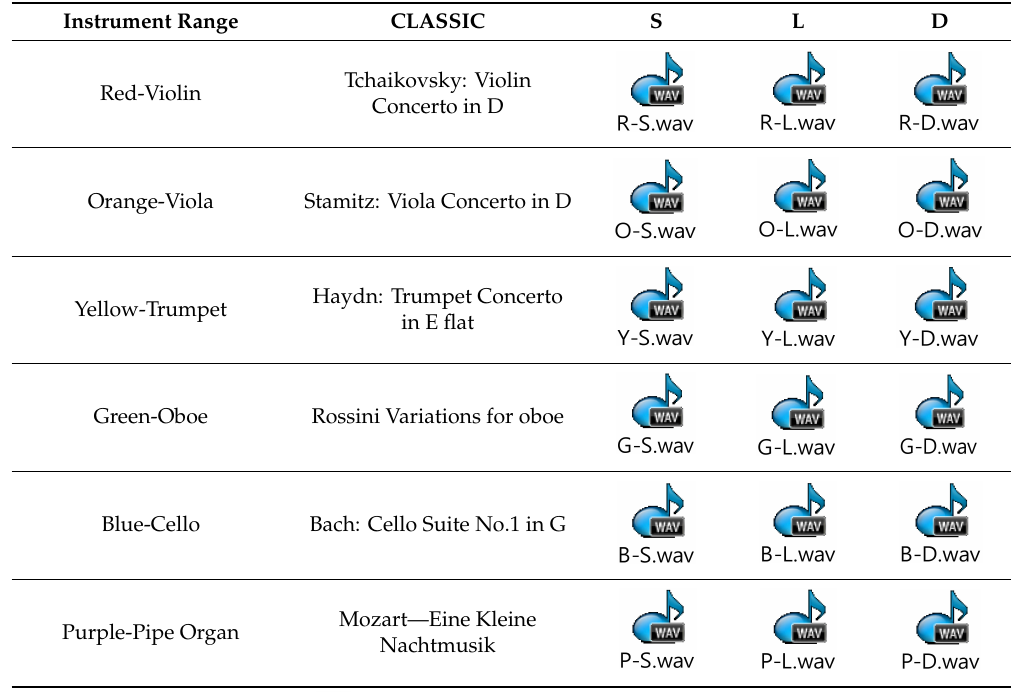
Table 5. CLASSIC SCC V2 with wav